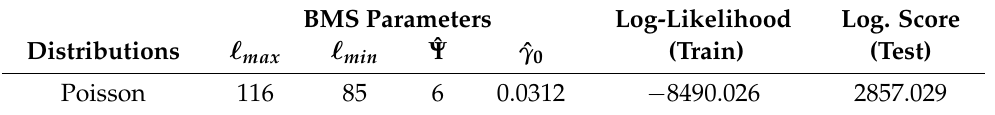
Table 3. Results of the Poisson BMS